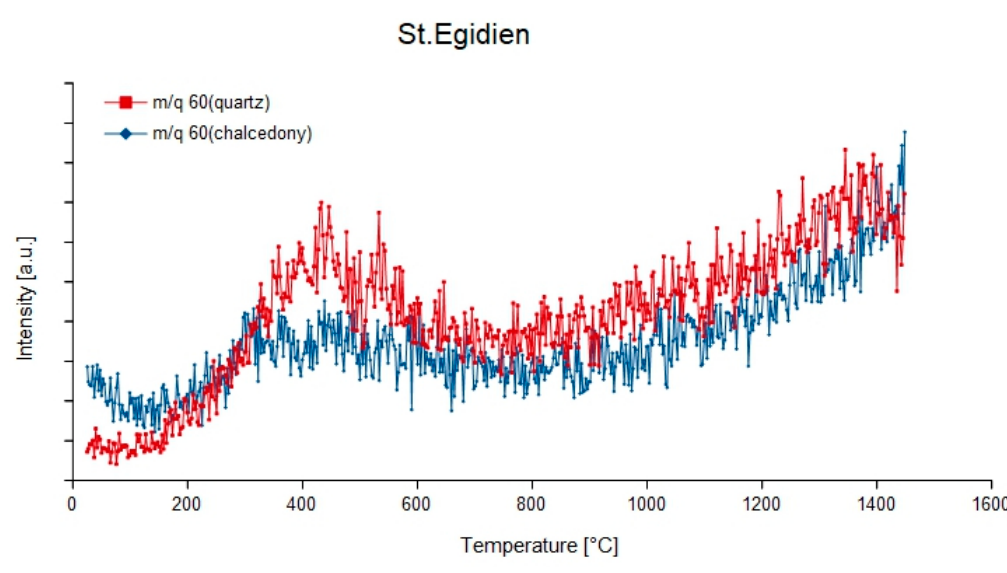
Figure 11. Degassing curves of m/q = 60 ( 12 C 16 O 32 − ) of quartz and chalcedony in agate from St. Egidien, Germany.